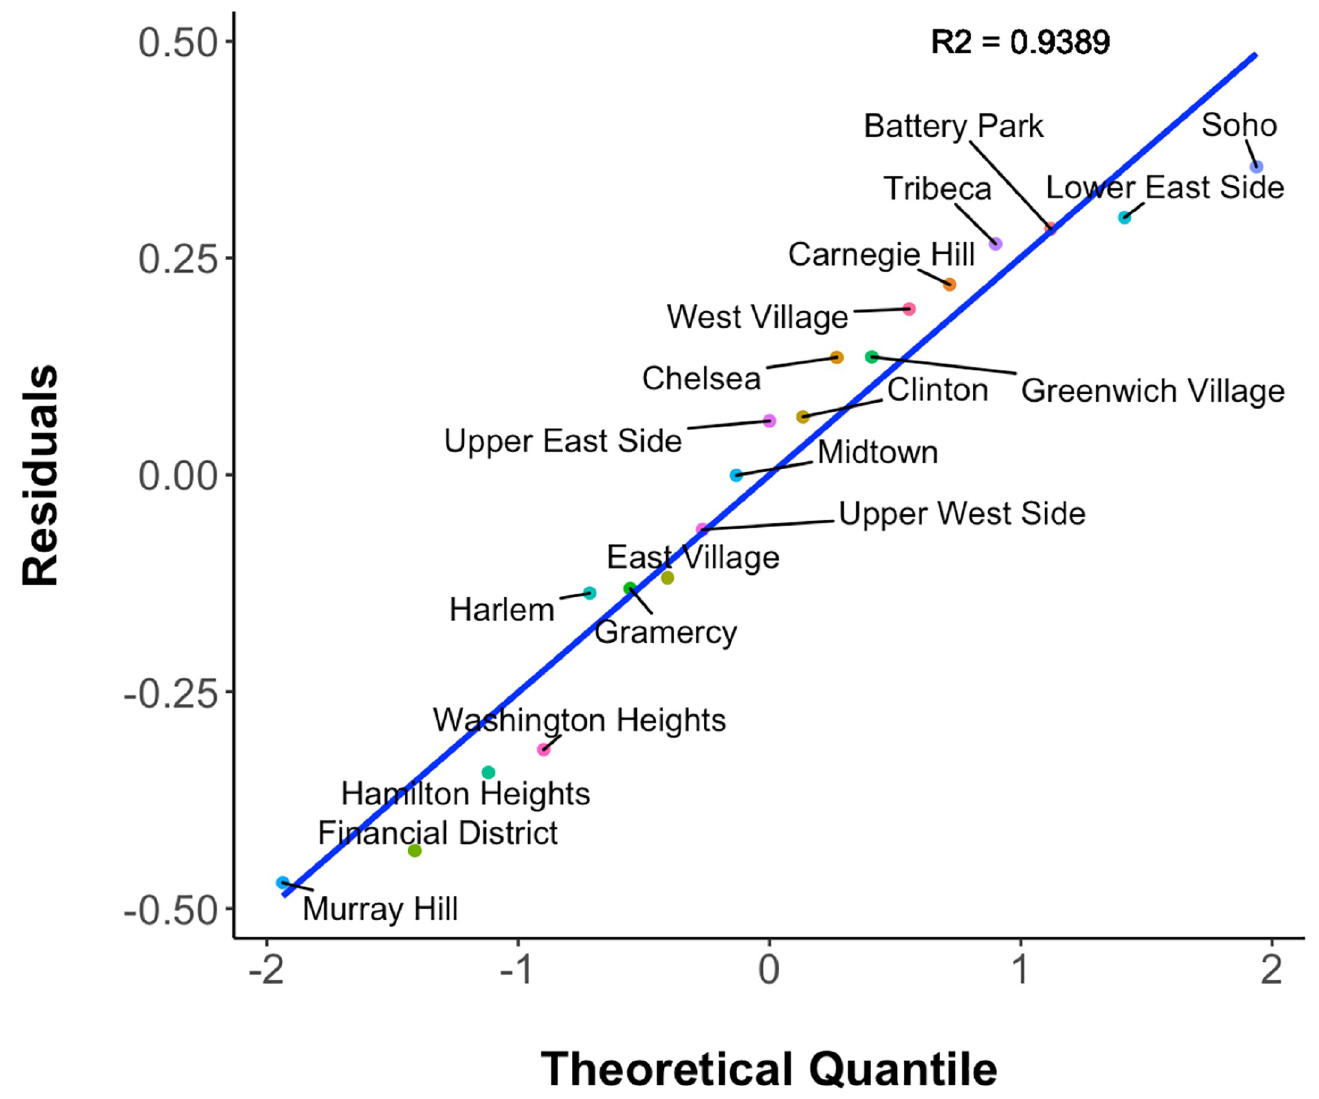
Fig 16. Q-Q plot of residuals of scaling relationship model.